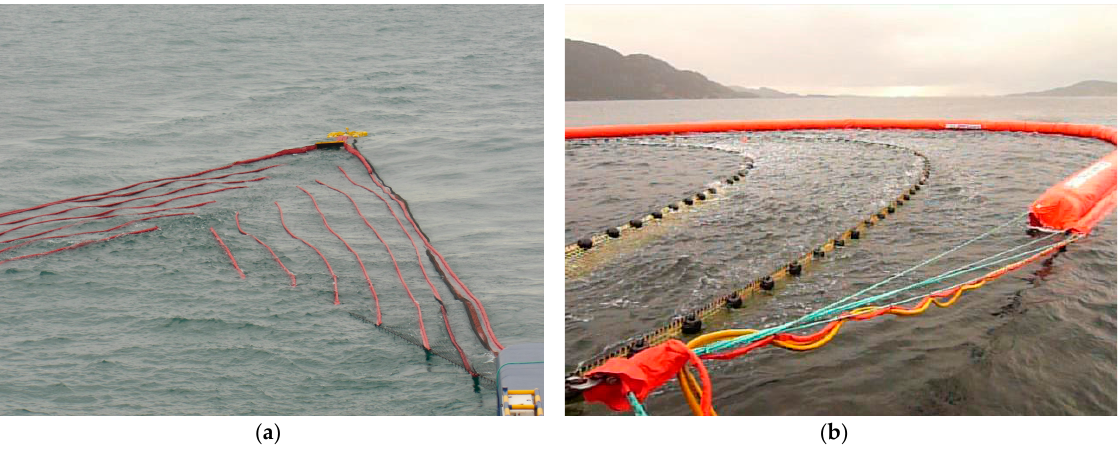
Figure 2. NOFO’2015 oil spill cleanup exercise: ( a ) MOS Sweeper and ( b ) DESMI Boom recovery systems tested on 9 June 2015 (photographs provided by NOFO).